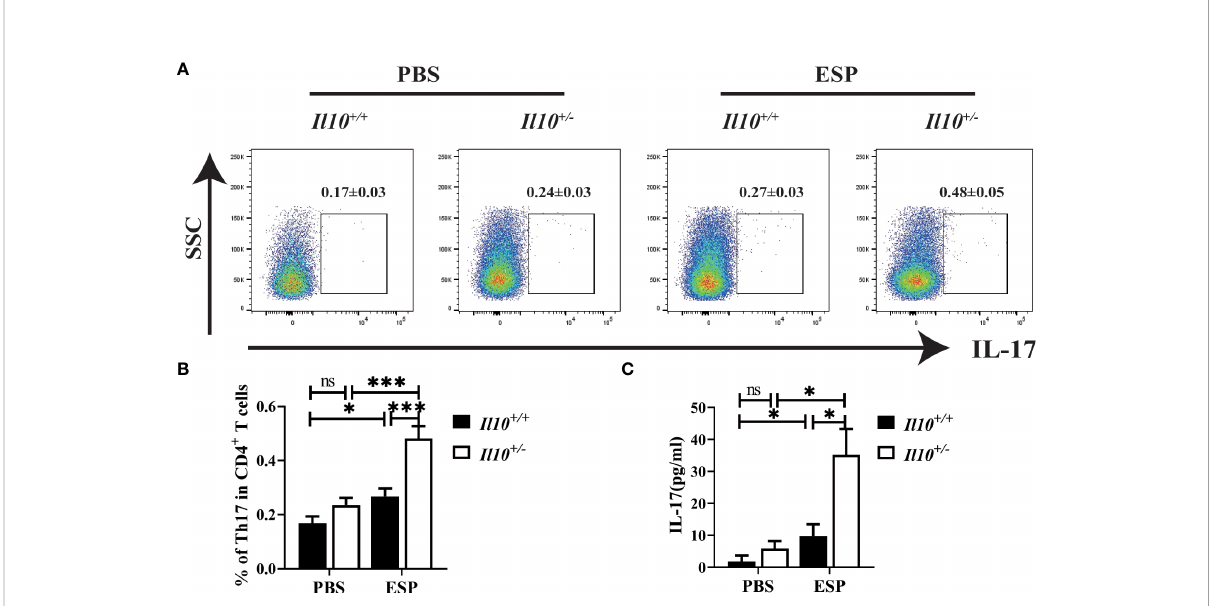
FIGURE 5 The increased proportion of Th17 cells in CD4 + T cells induced by ESPs stimulation is enhanced with IL-10 de fi ciency. The Il10 +/+ mice and Il10 +/- mice were sacri fi ced, and single-cell suspensions of splenocytes were prepared for ESP stimulation. (A) The expressions of IL-17 gated in CD4 + T cells are analyzed by fl ow cytometry. (B) The ratio of Th17 cells in CD4 + T cells. (C) The concentration of IL-17 in the supernatant was analyzed by ELISA. Compared with indicated group, * P < 0.05, *** P < 0.001, ns, no signi fi